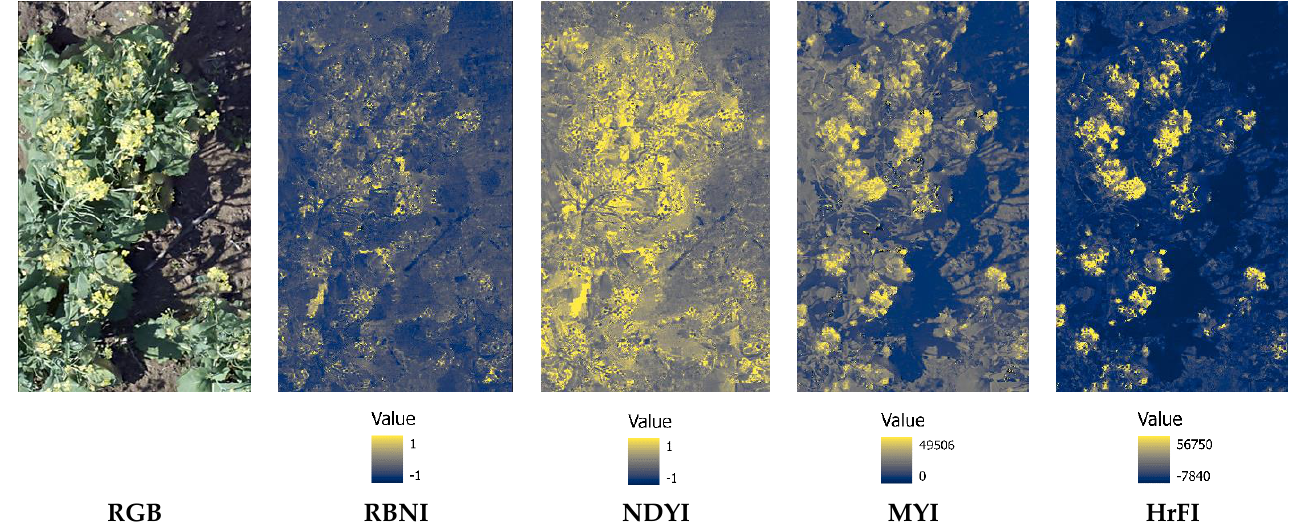
Figure 4. Visual comparison of a clip of the orthomosaic acquired on 4 July, and the four corresponding vegetation indices, RBNI, NDYI, MYI, and HrFI. RBNI: Red Blue Normalizing Index, NDYI: Normalized Difference Yellowness Index, MYI: Modified Yellowness Index, HrFI: High-resolution Flowering